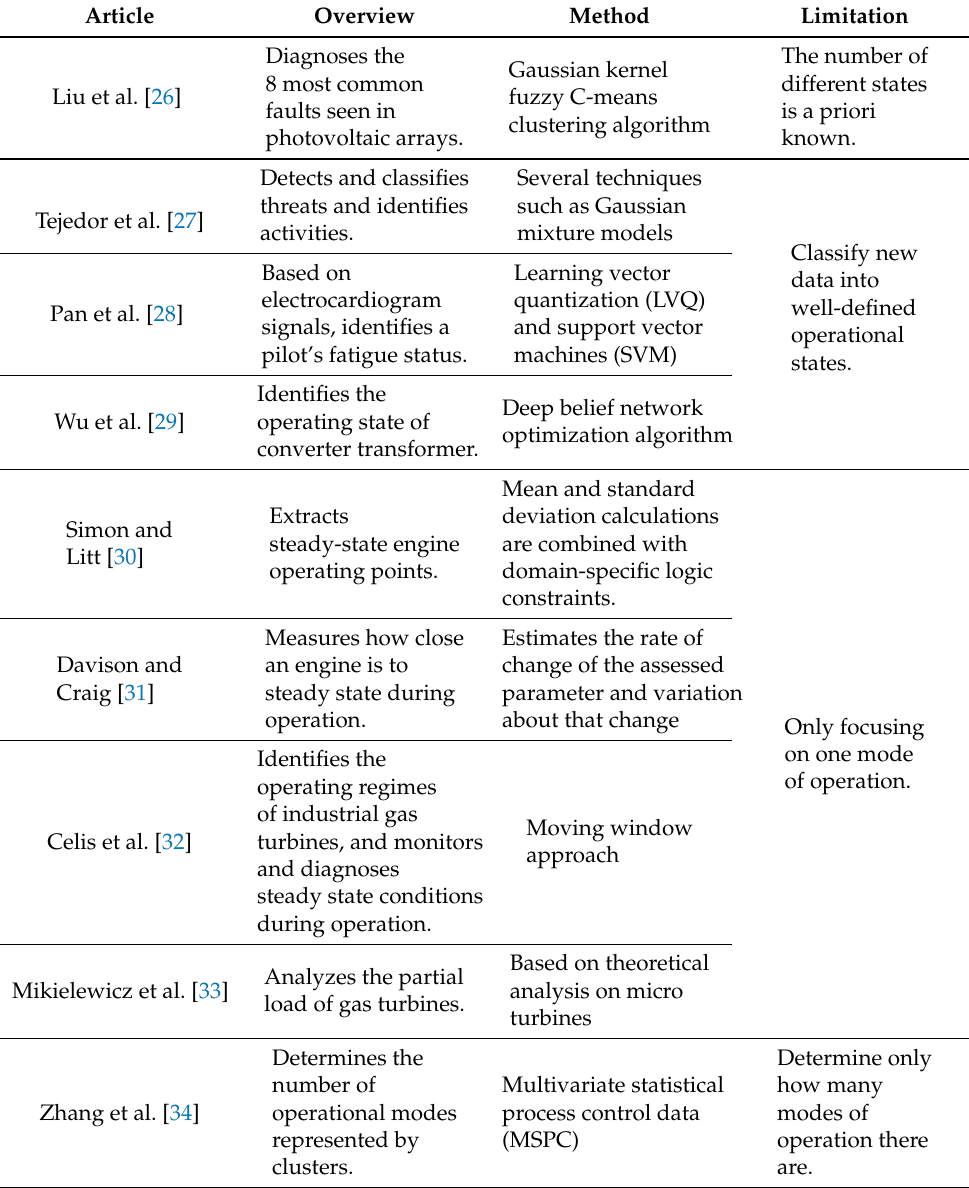
Table 1. Survey of similar studies on operational states/modes detection in the